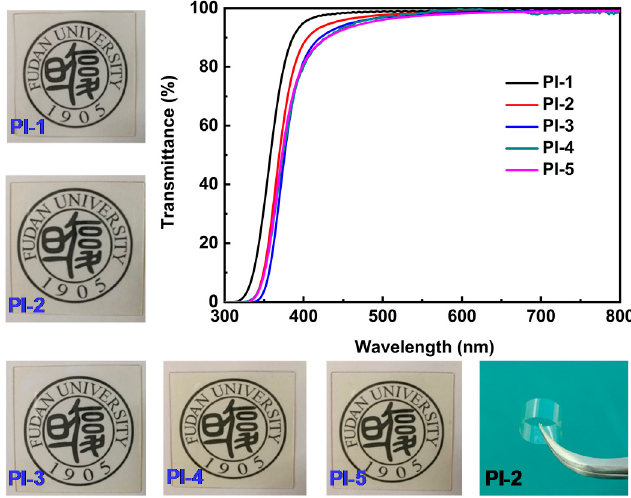
Figure 2. Photographs and transmittance of pure PI and PI-POSS hybrid films with thickness about 15 µm.